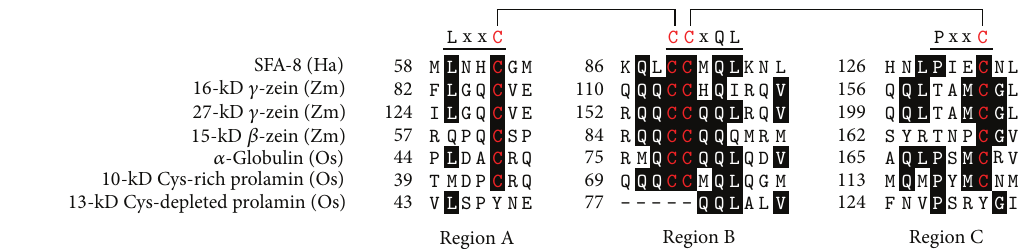
Figure 3: Conserved Cys residues in members of the prolamin superfamily. Amino acid sequences in regions A, B, and C of Zea mays (Zm) and Oryza sativa (Os) storage proteins are compared to Helianthus annuus (Ha) SFA-8. Amino acid sequences of SFA-8 (CAA40015), 16-kD 𝛾 -zein (NP 001105337), 27-kD 𝛾 -zein (NP 001105354), 15-kD 𝛽 -zein (NP 001106004), 𝛼 -globulin (BAA09308), and Cys-rich 10-kD prolamin (crP10; NP 001051380) were aligned by means of CLUSTALW. For comparison, the corresponding sequence of Cys-depleted 13-kD prolamin (cpP13; NP 001055213) is shown. Two disulfide bonds in SFA-8, Cys62–Cys89 and Cys90–Cys132, are indicated with solid lines. Red-on-black letters indicate Cys residues; white-on-black letters indicate amino acid residues conserved in at least four of the sequences analyzed.